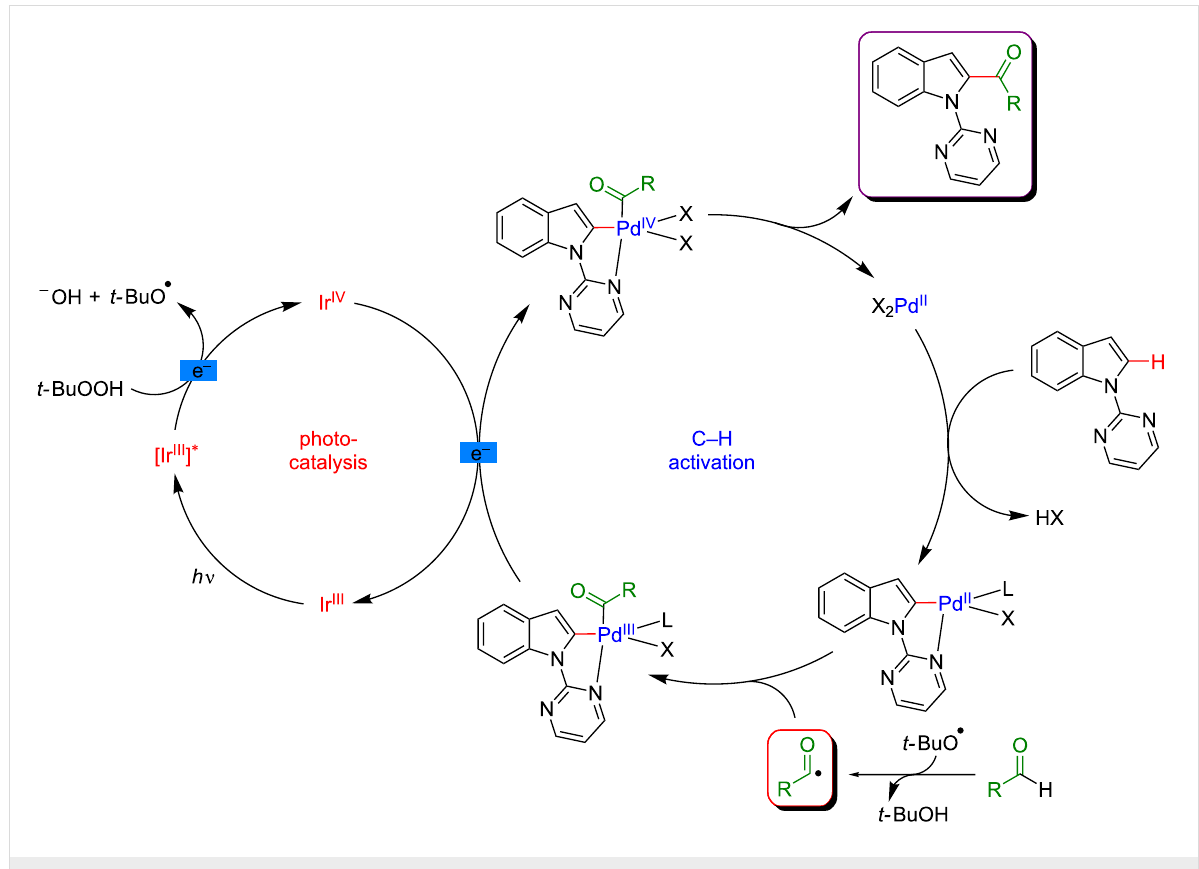
Figure 31: Proposed mechanism for the C2-acylation of indoles with aldehydes via dual catalysis.